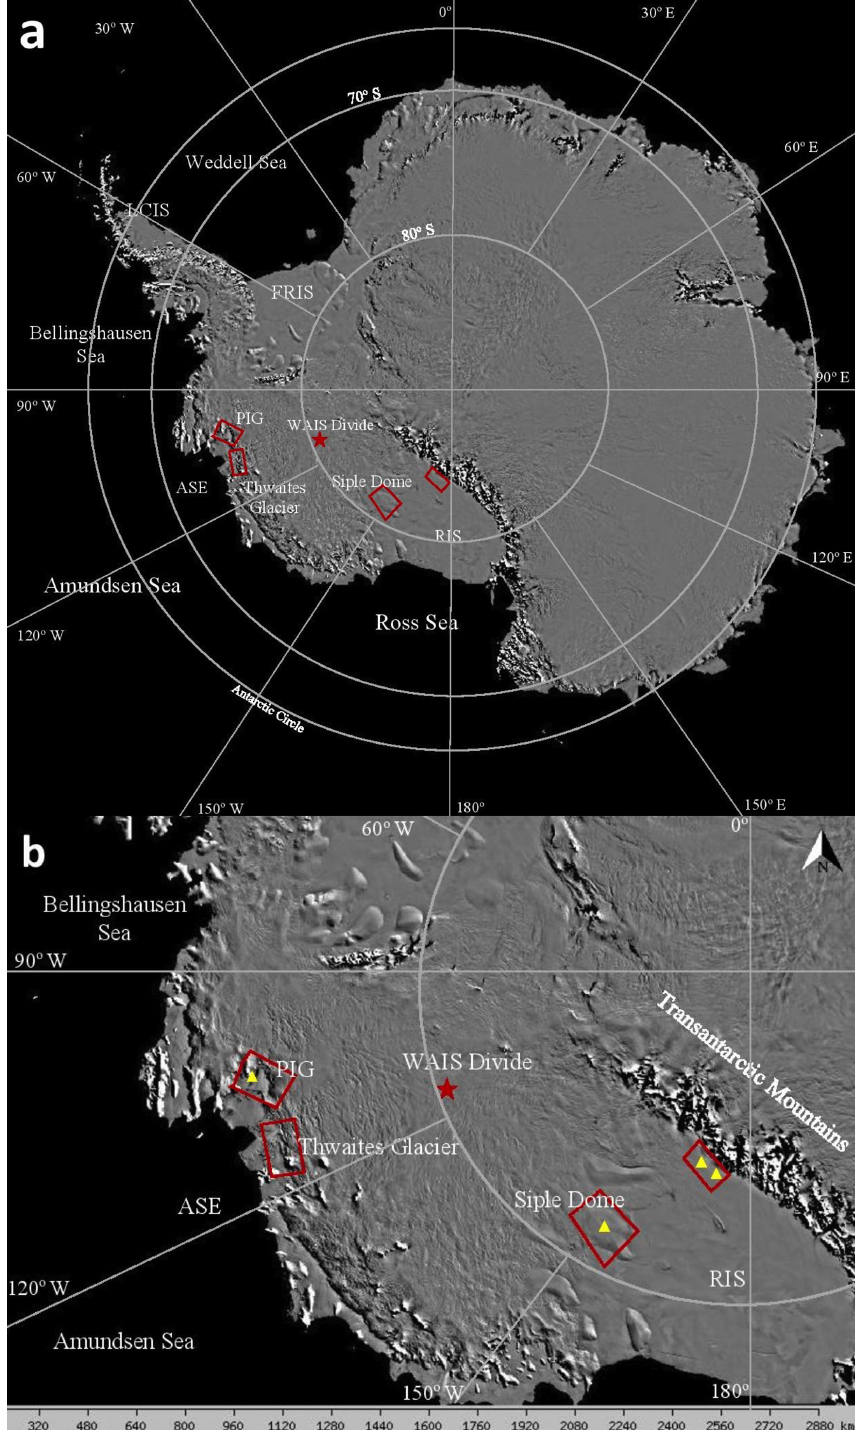
Figure 1. Maps of (a) Antarctica and (b) West Antarctica showing the case study locations. The red boxes depict the regions from which the satellite and reanalysis data are extracted for analysis. The AWARE data were collected at the WAIS Divide ice camp, shown by the red star. The locations of automatic weather stations are shown as yellow triangles. Abbreviations are Ross Ice Shelf (RIS), Amundsen Sea Embayment (ASE), Pine Island Glacier (PIG), Filchner–Ronne Ice Shelf (FRIS), and Larsen C Ice Shelf (LCIS). Figure constructed from the Mosaic of Antarctica (Scambos et al. 2007; Haran et al.,